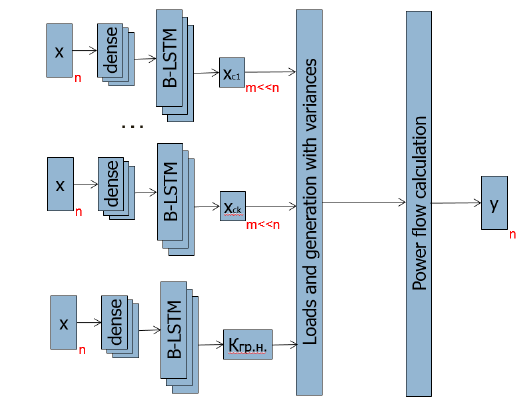
Fig. 12. Neuro-analytical